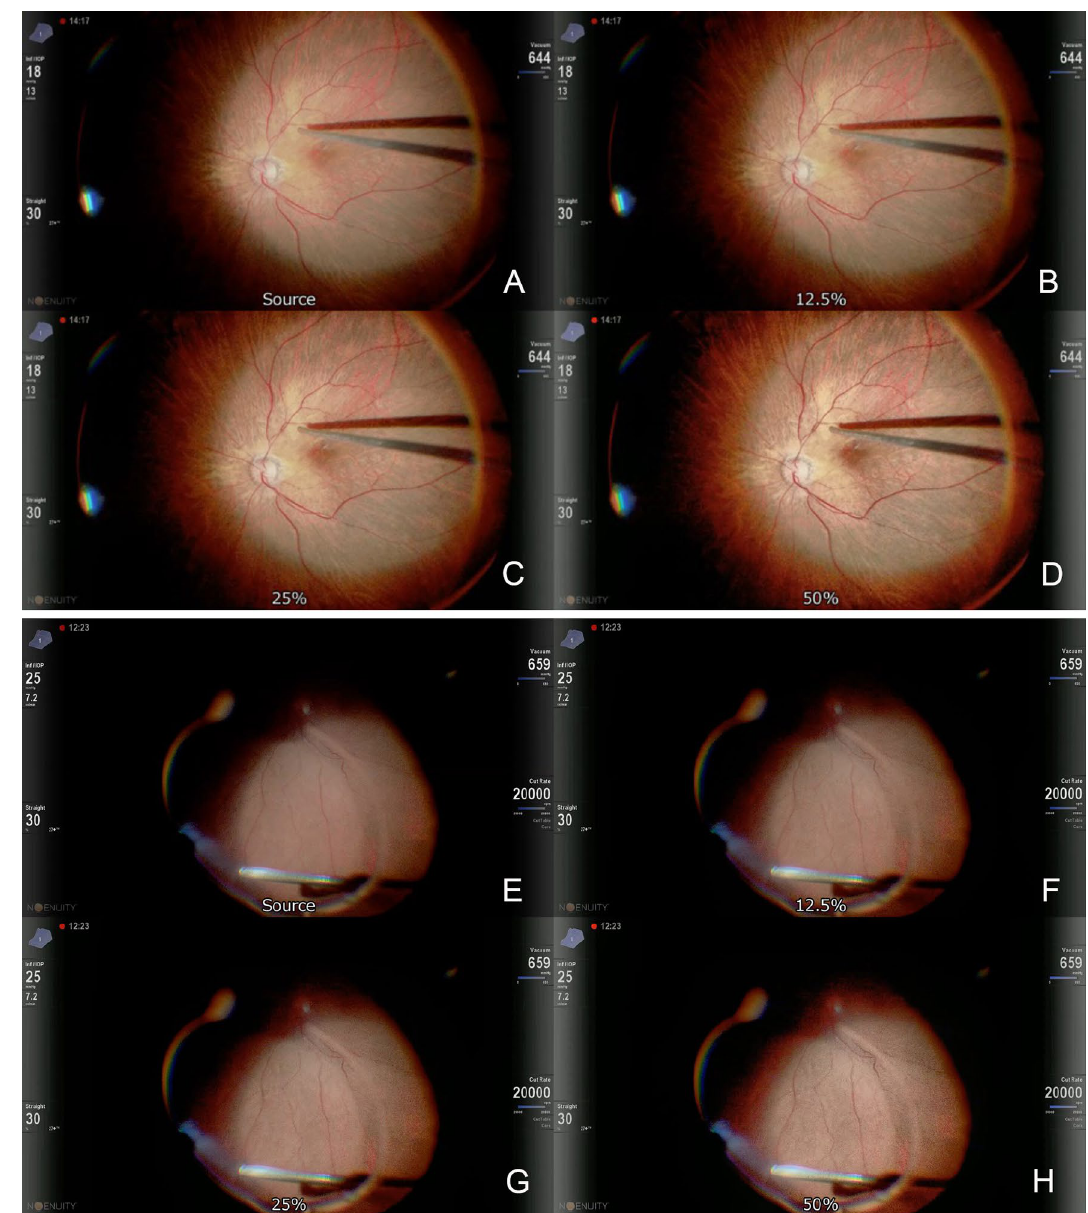
Figure 4. Surgical images during core vitrectomy. Surgical images during core vitrectomy under a wide-angle viewing system with the original image ( A ), 12.5% ( B ), 25% ( C ), and 50% ( D ) intensity of image-sharpening showing that the retinal image and the pattern of the retinal vessel and choroidal vessels are more clearly delineated in the shadow of the intraocular illumination with the increase of the image-sharpening. Surgical images during peripheral vitrectomy under a wide-angle viewing system with the original image ( E ), 12.5% ( F ), 25% ( G ), and 50% ( H ) intensity of image-sharpening indicate that the vitreous fibers illuminated by the intraocular illumination are more clearly depicted with the increase of the image-sharpening